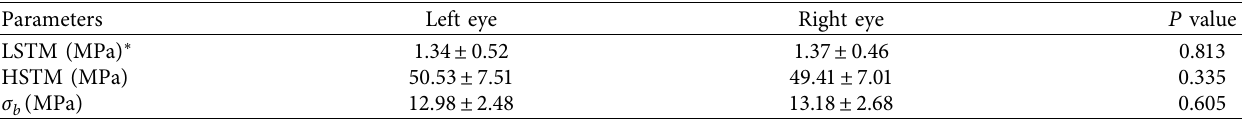
Figure 3: Stress-strain measurements of left and right eyes. Table 2: Comparison of left and right